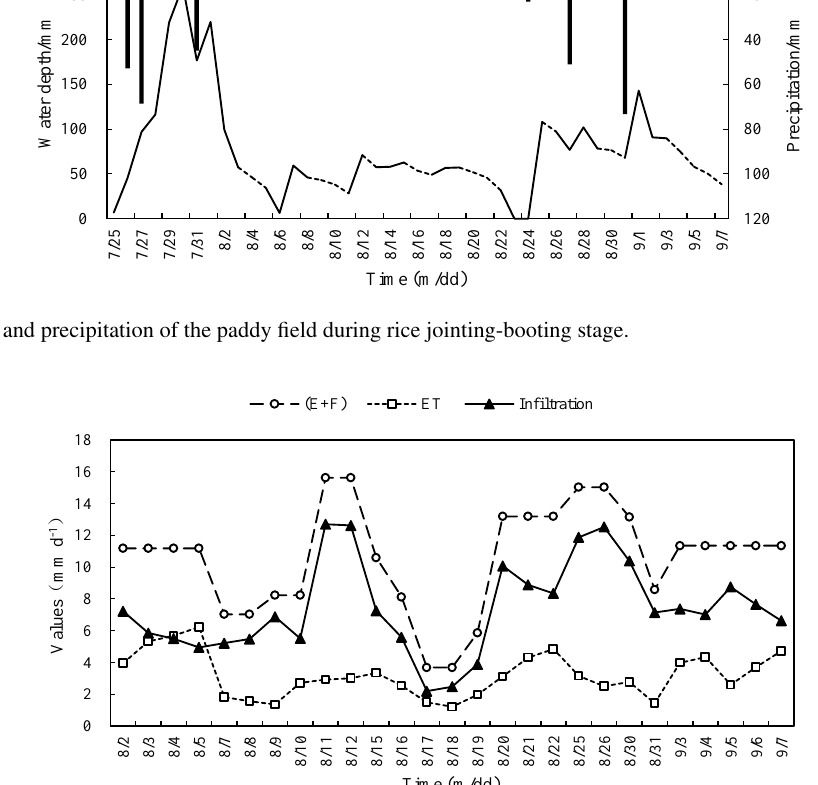
province (Cabangon et al., 2004). The research observed the vertical infiltration through the plough pan and the lateral seepage on sloping land formed into terraces and showed that the higher the position on sloping land was, the greater the potential of water losses was because of higher vertical in- filtration and lateral seepage (Tsubo et al., 2005). The study carried out in Taiwan indicates the vertical infiltration and lateral seepage rates of the flat paddy field through the bottom of the ridge were 4.0 and 3.3 mm day − 1 respectively with the plow sole underneath, and 8.5 and 4.5 mm day − 1 respec- tively without the plow sole underneath (Huang et al.,